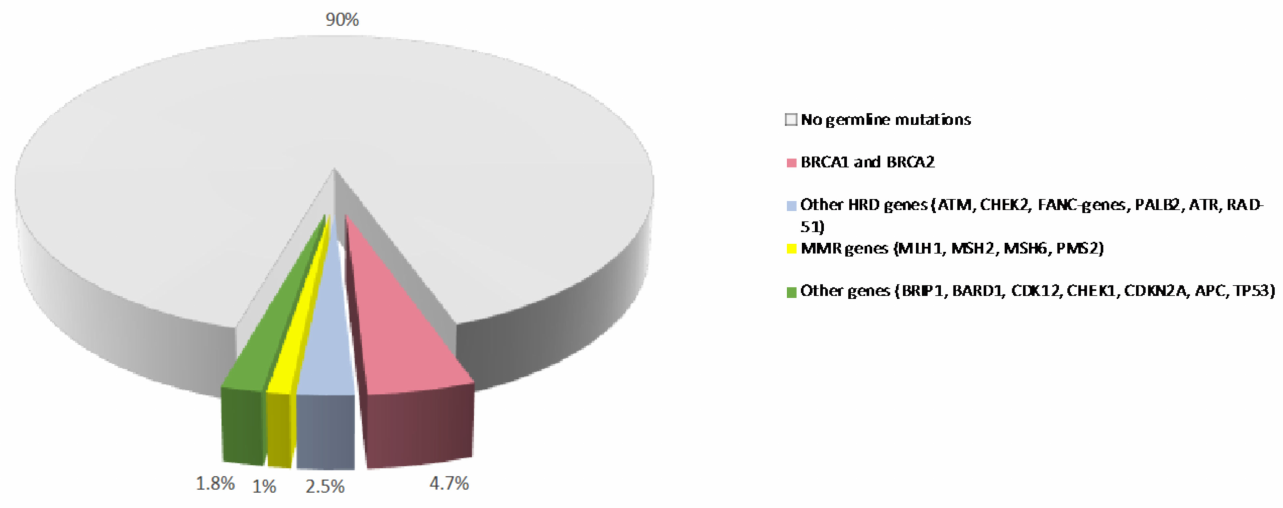
Figure 1. Prevalence of germline variants in PDAC. Prevalence of germline mutations in PDAC patients from published studies. MMR: mismatch repair. HR: homologous